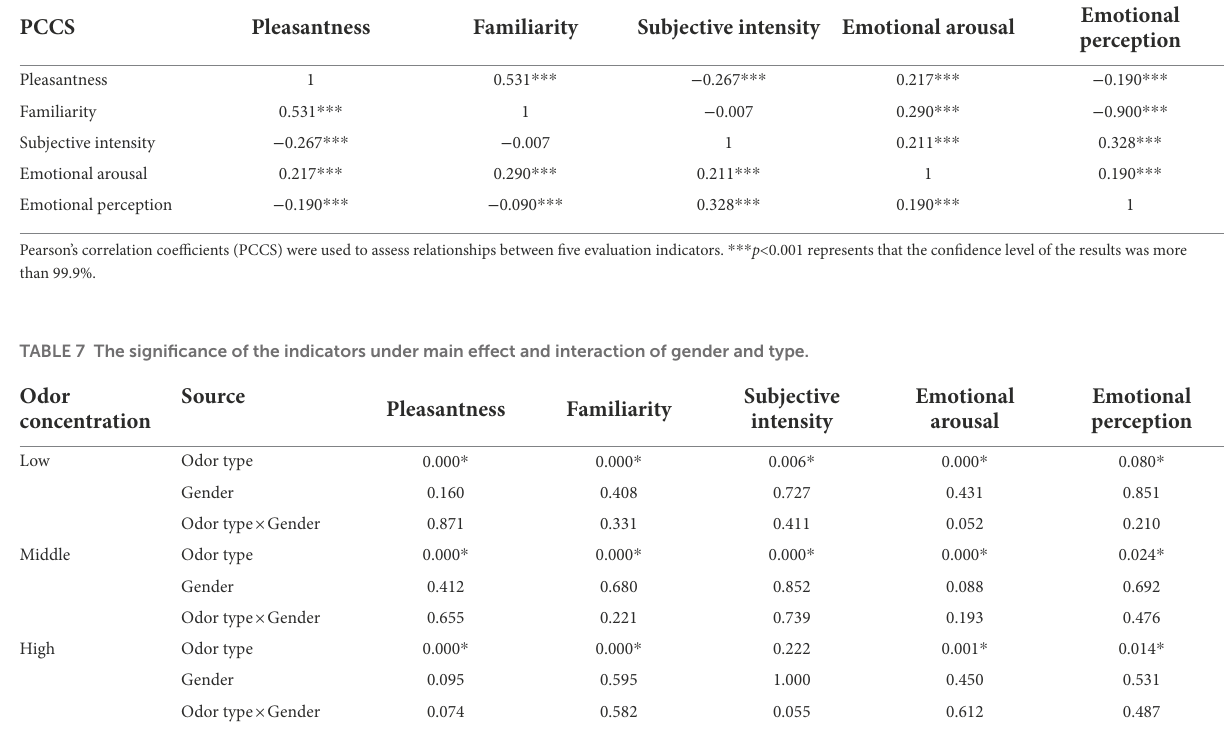
TABLE 6 Correlation between sensory evaluation indexes.